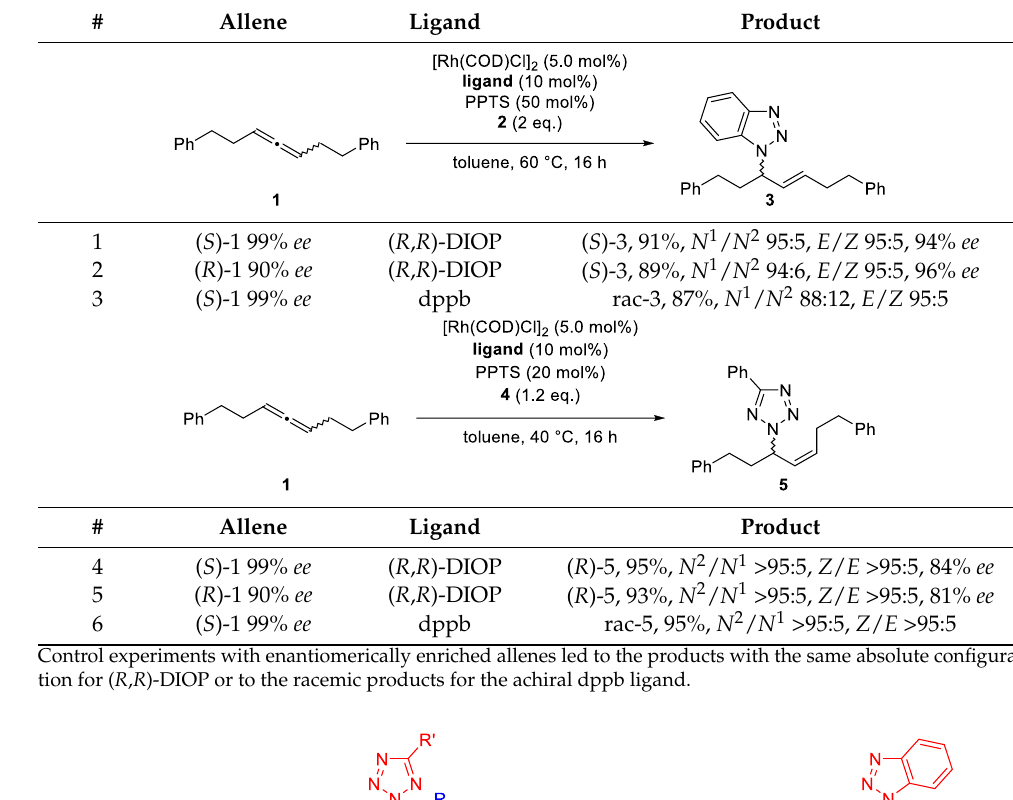
Table 1. Control experiments with enantioenriched